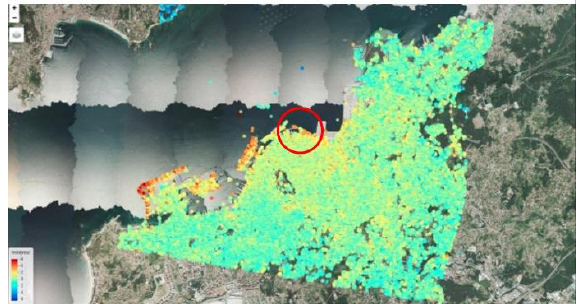
Figure 5 . Displacement recorded in the study area with StaMPS and the location of the pier in red circle.